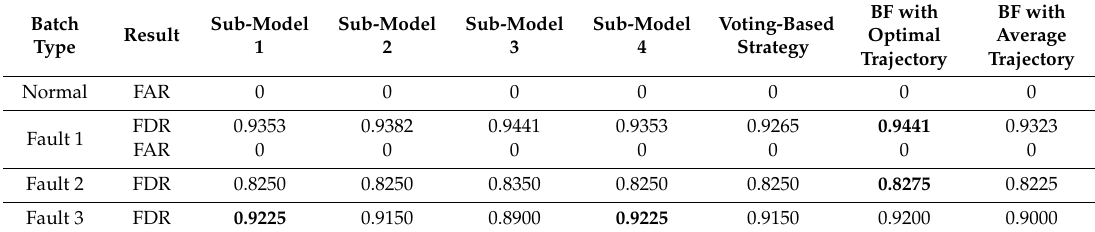
Table 7. FAR and FDR under di ff erent ensemble strategies in penicillin fermentation